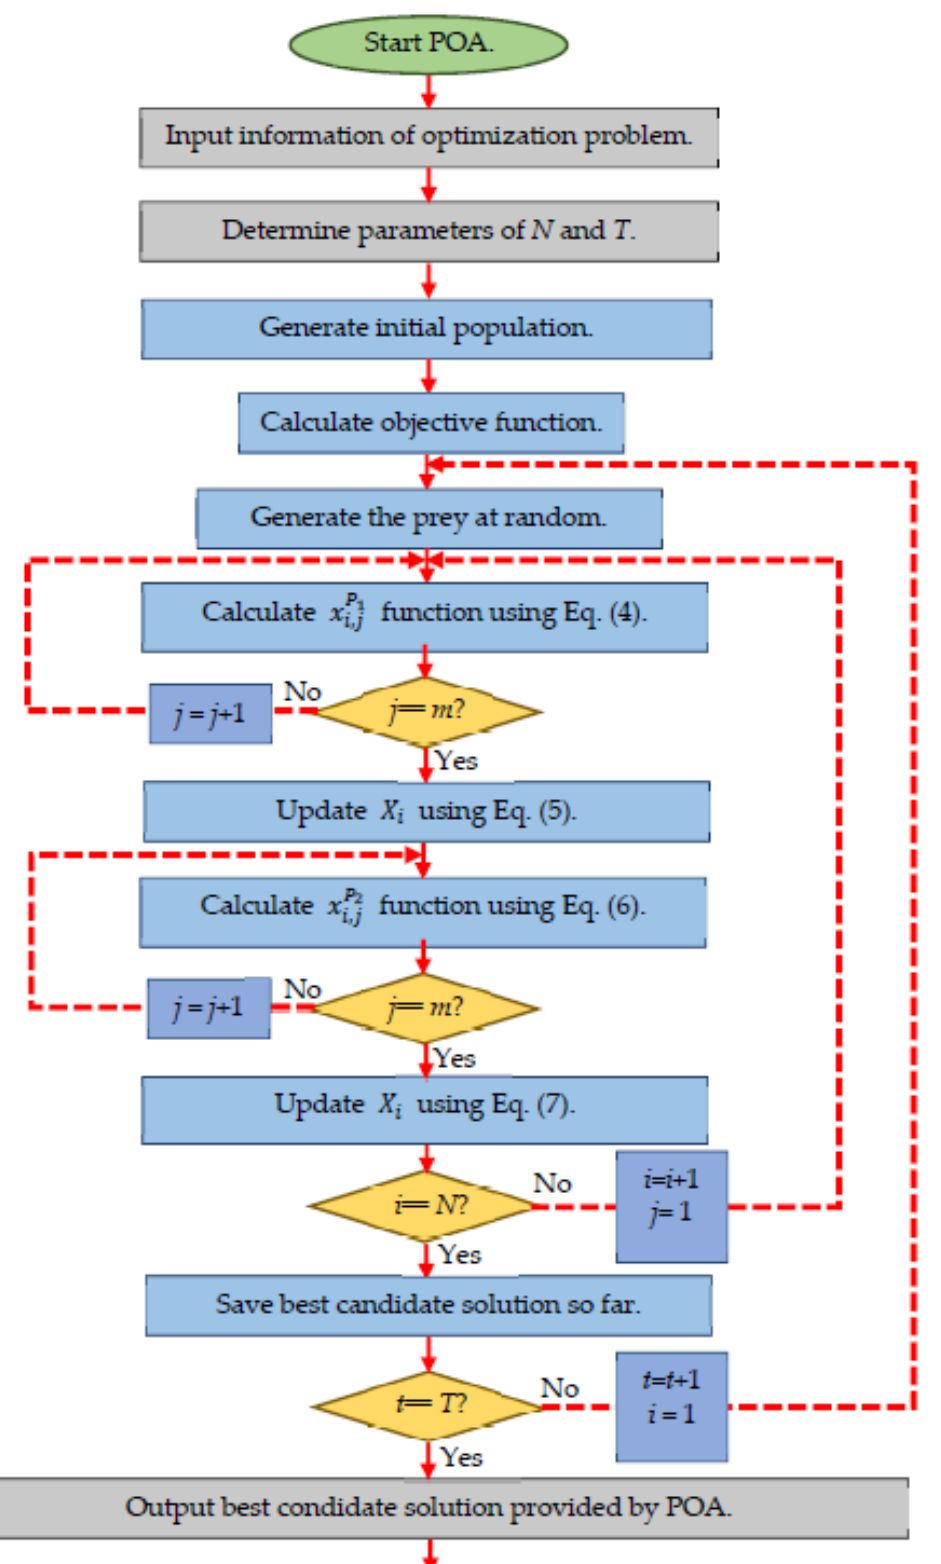
Figure 1. Flowchart of POA.